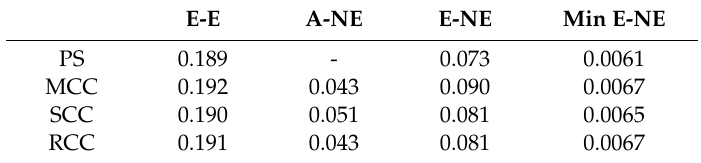
Table 6. Gower’s genetic distance values between accessions in the primary set and core collections.